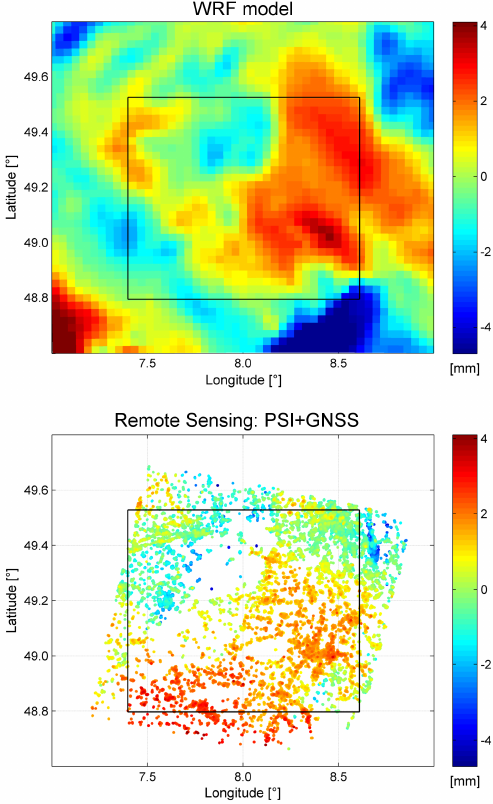
Figure 11. PWV maps from the PSI+GNSS combination and WRF on 5 September 2005, with a linear trend subtracted from each map. PSI+GNSS provide point-level observations, while WRF generates block data with a block size of 3km × 3km. The predictions will be obtained within the area indicated by the black